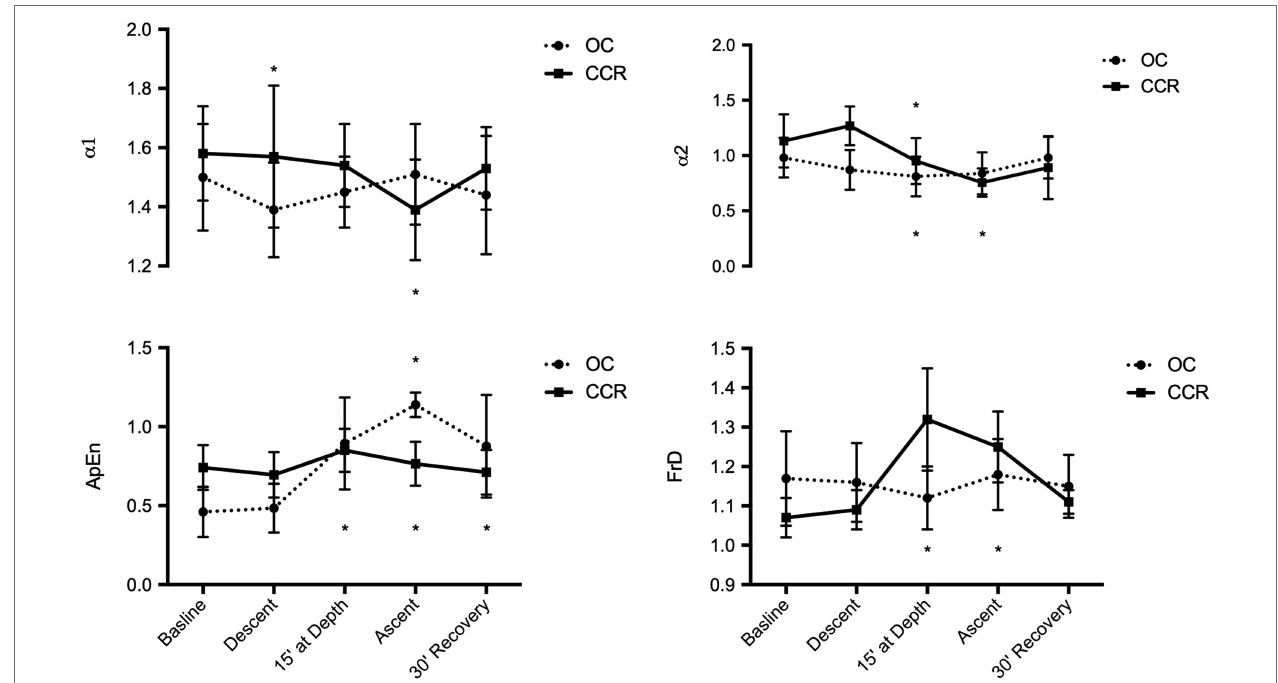
FIGURE 3 | Fractal analysis of HR variability. α 1 & α 2, fractal-like scaling exponent; ApEn, approximate entropy; and FrD, fractal dimension * p <